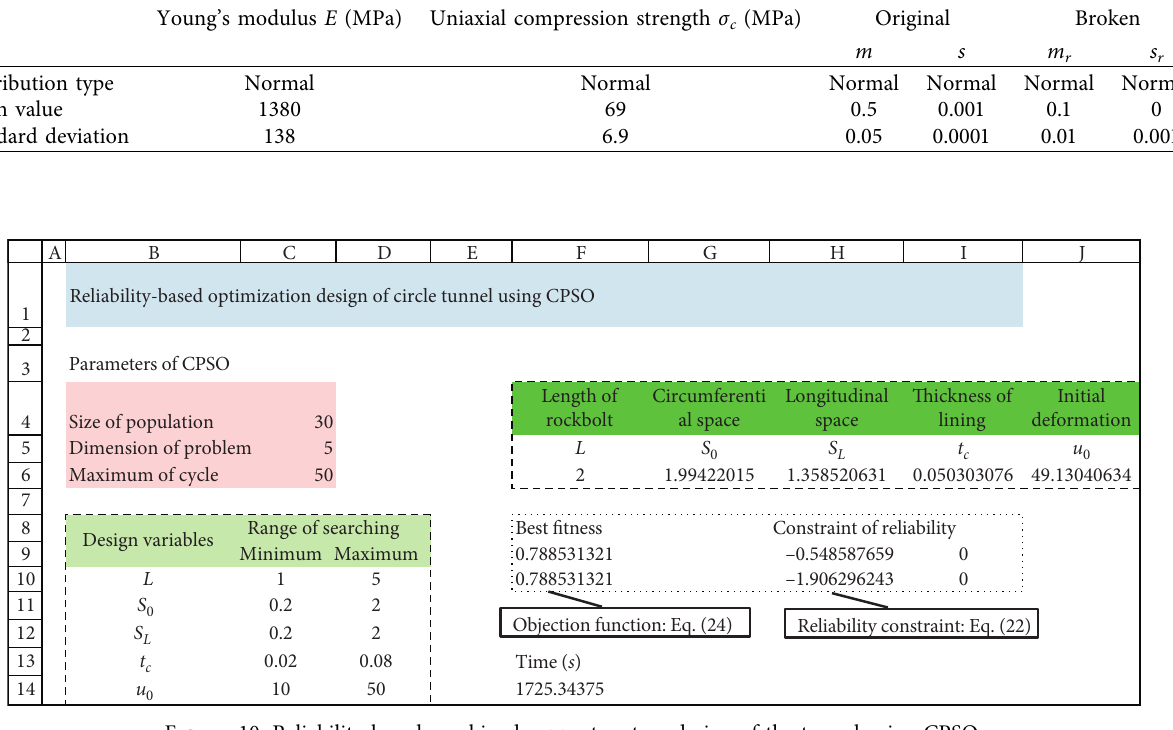
Figure 10: Reliability-based combined support system design of the tunnel using CPSO.